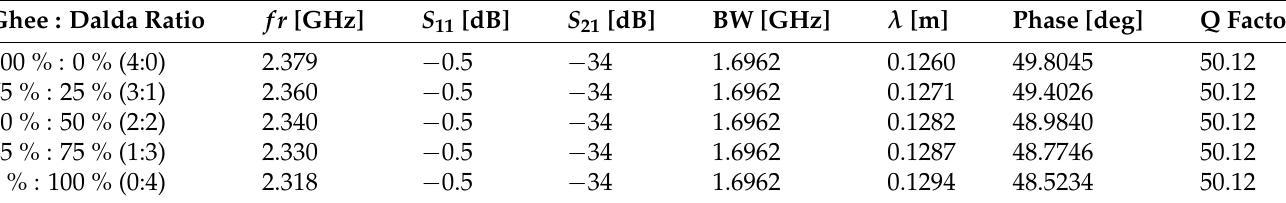
Figure 28. Adulteration testing in ghee ( a ) Experimental setup ( b ) Variation of scattering parameters with frequency ( c ) Variation of transmission coefficient parameters with frequency. Table 10. Adulteration testing in